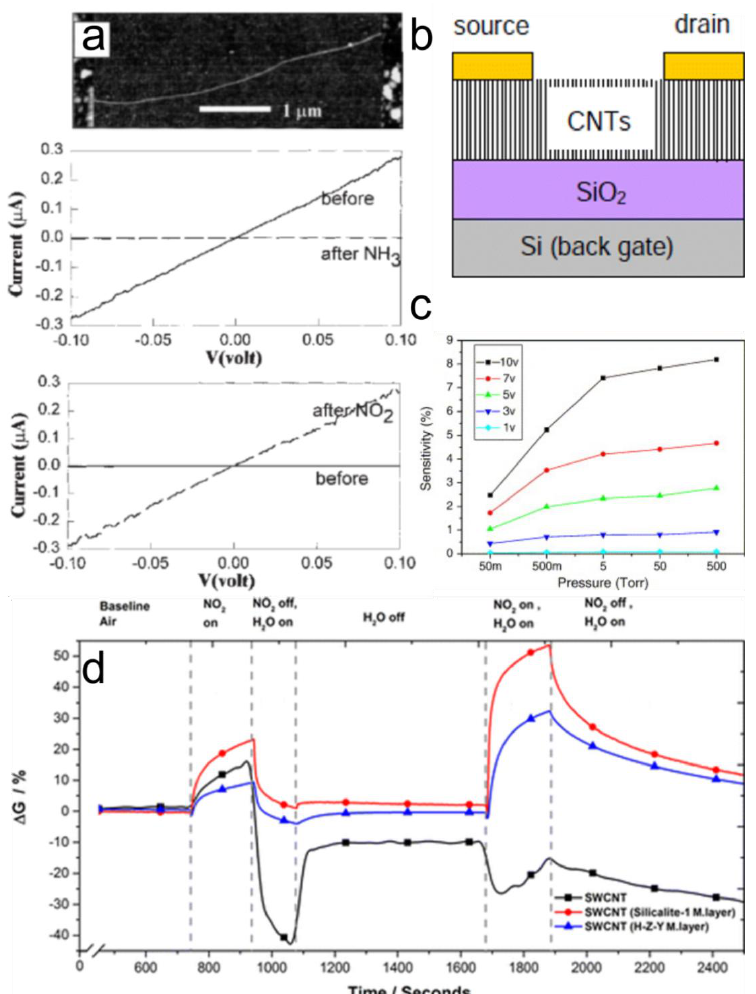
Figure 2. ( a ) Atomic force microscopy image of an individual semiconducting SWCNT bridging two metal contacts; and its current versus voltage curves collected before and after exposure to NH 3 or to NO 2 . Modified from Ref. [18]. with permission from American Association for the Advancement of Science (AAAS) ( b ) Schematic of a three-terminal gas sensor with silicon substrate as back gate and